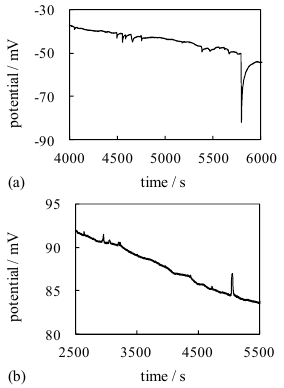
Figure 8. Membrane potential generated across ( a ) a silver wire & S ‐ penta and ( b ) a silver wire & C ‐ penta.